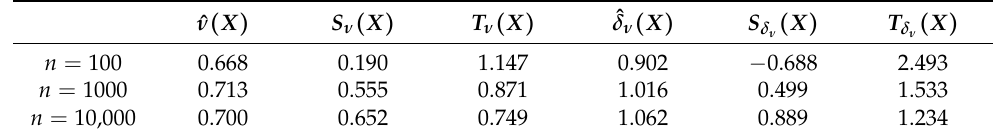
Table 4. Values of the estimates of the parameters ν and δ with the corresponding asymptotic confidence intervals for the true values of the parameters r = 0.5, ν = 0.7, s = 1.5, t = 0.6, δ = 1.